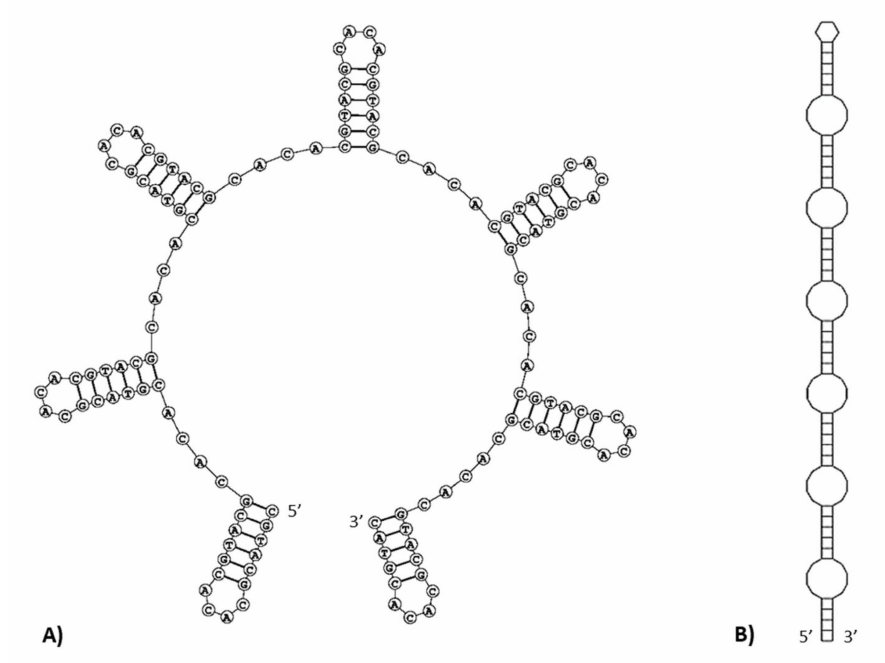
Figure 8. Putative single-strand hairpin structures predicted for an inverted repetitive sequences rich region within the control region of the European mink mitogenome (( A )—structure of a linear stem-loop set, ( B )—simplified scheme of a contiguous stem